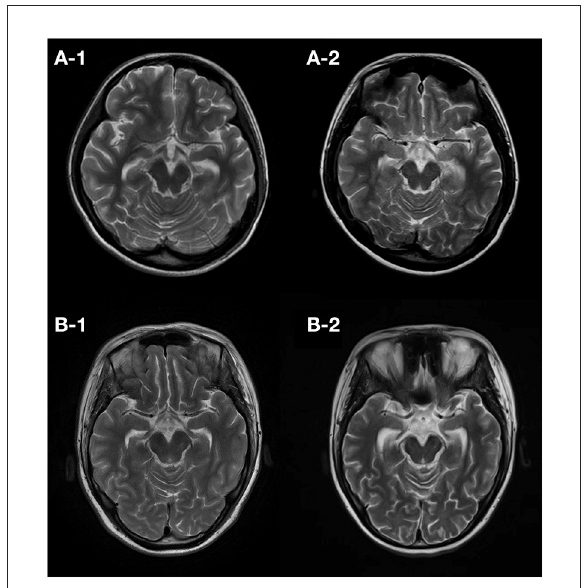
FIGURE3 Follow-up T2 images of patients developing atrophy. Patient 7 had an initial normal brain MRI (10 days from onset) and showed hippocampal atrophy 50 days (A-1) and 72 months (A-2) later. Patient 11 also had an initial normal MRI (2 days from onset) and showed hippocampal atrophy 3 months (B-1) and 16 months (B-2)